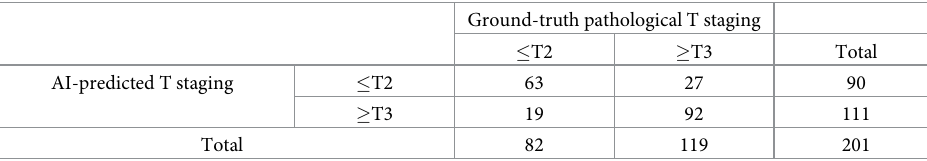
Table 2. Summary of pathological T stage and AI-predicted T